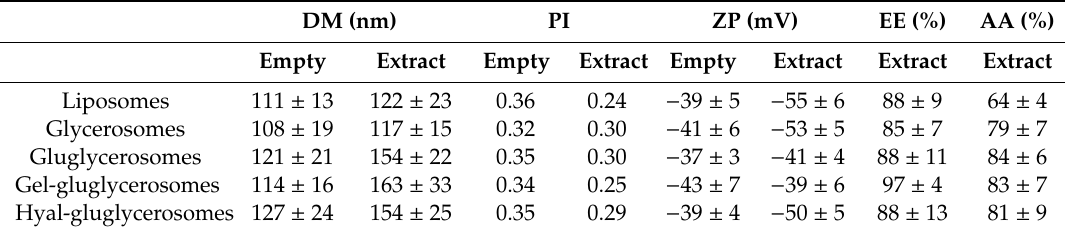
Table 2. Mean diameter (MD), polydispersity index (PI), zeta potential (ZP), and entrapment efficiency (EE) of H. scruglii extract-loaded vesicles. Mean values ± standard deviations are reported (n = 6).